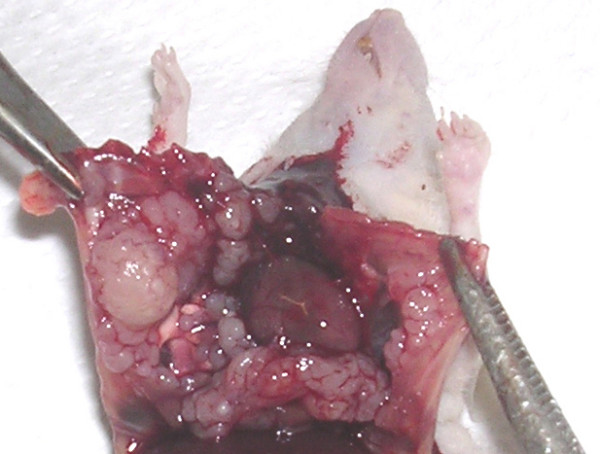
Pleural MPM nodules. IST-Mes3 cells (2 × 106 in 100 μl of HBSS) were injected into the left pleural cavity of nude mice. Tumor masses completely invaded the thoracic and visceral pleural and the lungs. The irregular growth of this cell line is evidenced by a major bulk of tumor in the right chest.